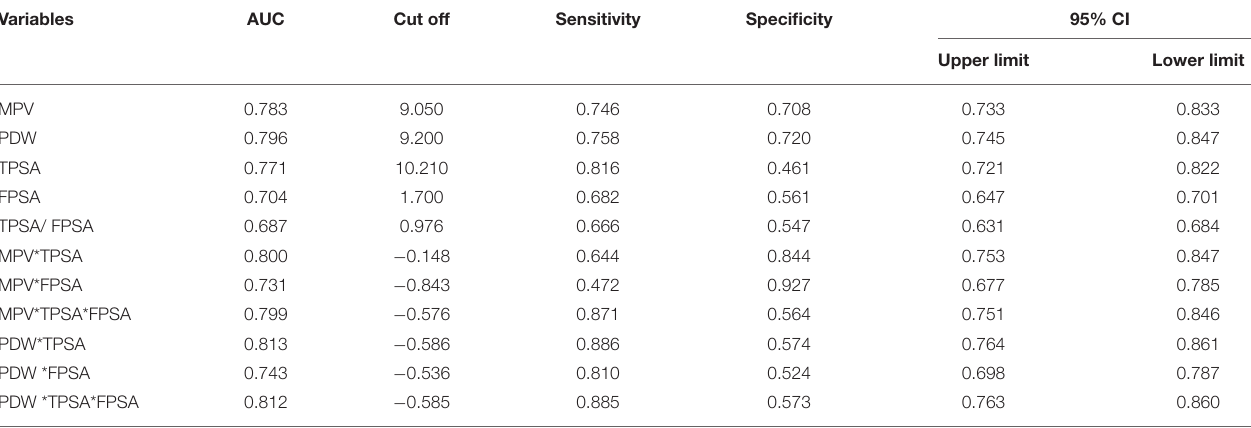
TABLE 4 | Diagnostic value of MPV, PDW, TPSA, and FPSA biomarkers for PCa. Variables AUC Cut off